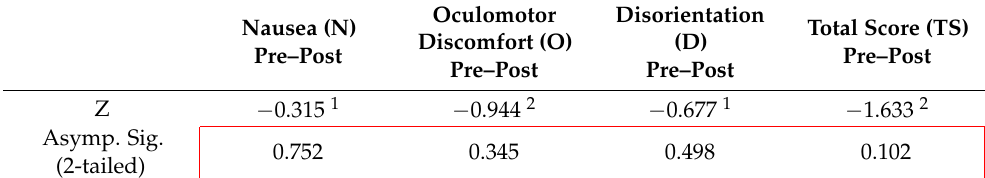
Table 19. Results of the Wilcoxon signed rank test for SSQ scores for each